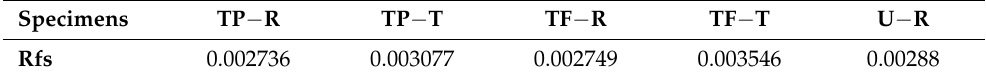
Table 3. Proportion of the maximum value of the first peak mass loss rate and the time to reach this. Specimens TP − R TP − T TF − R TF − T U − R Rfs 0.002736 0.003077 0.002749 0.003546